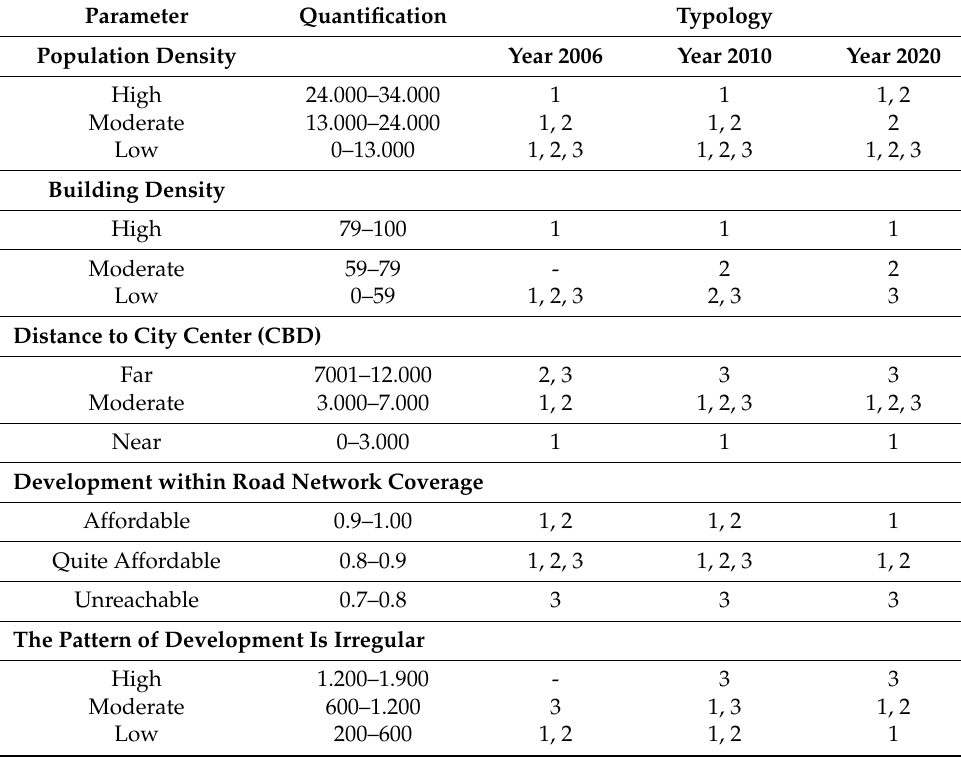
Table 5. Comparison of urban sprawl typology in Makassar City in 2006, 2010, and